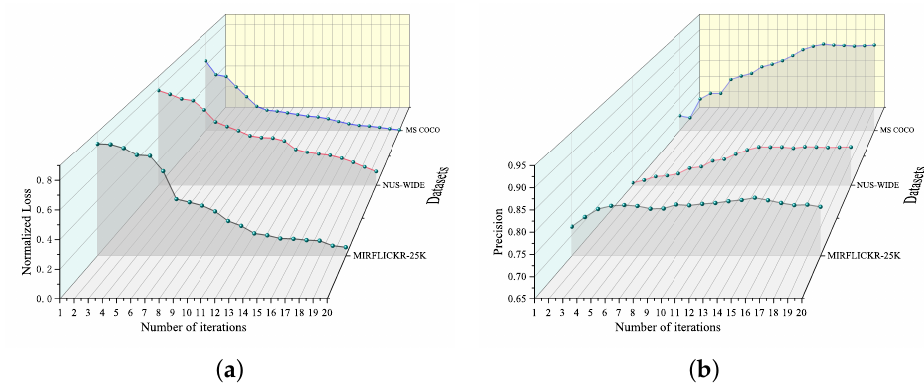
Figure 6. The loss function convergence curves and MAP change curves of the proposed CAGAN on three widely used multimedia datasets at 16-bit code length. ( a ) represents the loss change curve of the model as the number of training iterations increases. ( b ) indicates the retrieval accuracy (MAP@5000) curve of the model as the number of training iterations increases.